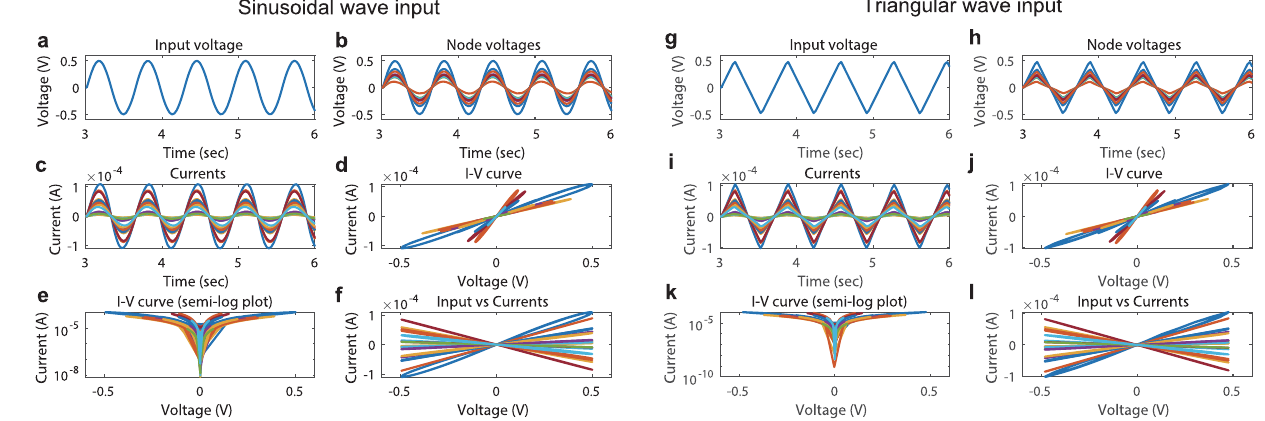
Figure 2. Dynamical behavior of a memristor-network-based reservoir driven by waveform signals. The network structure is the Rand-UP type, the average ON/OFF resistance ratio is ¯ r = 50 , and the degree of variability is σ = 0.2 . ( a ) A sine wave input. ( b ) The nodal voltages. ( c ) The currents on the memristor branches. ( d ) The I – V curves. ( e ) The same as ( d ), but the absolute current on a semi-log plot. ( f ) The currents plotted against the nodal voltages. ( g )–( l ) The same as ( a )–( f ), but for a triangular wave